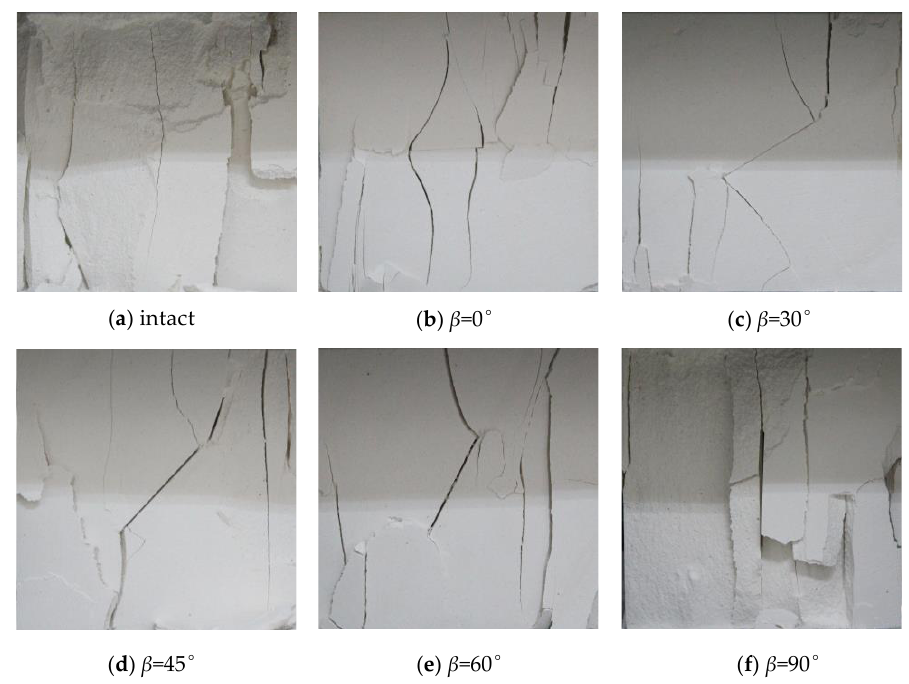
Figure 5. Photographs of specimens at selected key point S in the stress–strain curve.